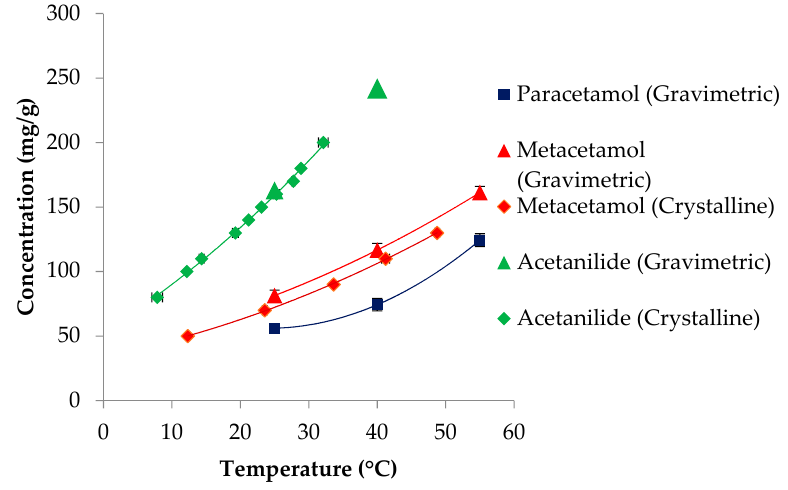
Figure 3. Solubility of paracetamol, metacetamol and acetanilide in 3-methyl-1-butanol obtained by isothermal equilibration followed by gravimetric analysis and by observing the dissolution temperature during heating using the Technobis Crystalline. Table 1. Molecular weights, melting points, enthalpy of fusion and measured solubilities of paracetamol, metacetamol and acetanilide determined using the gravimetric method. Compounds Molecular Weight (g/mol)